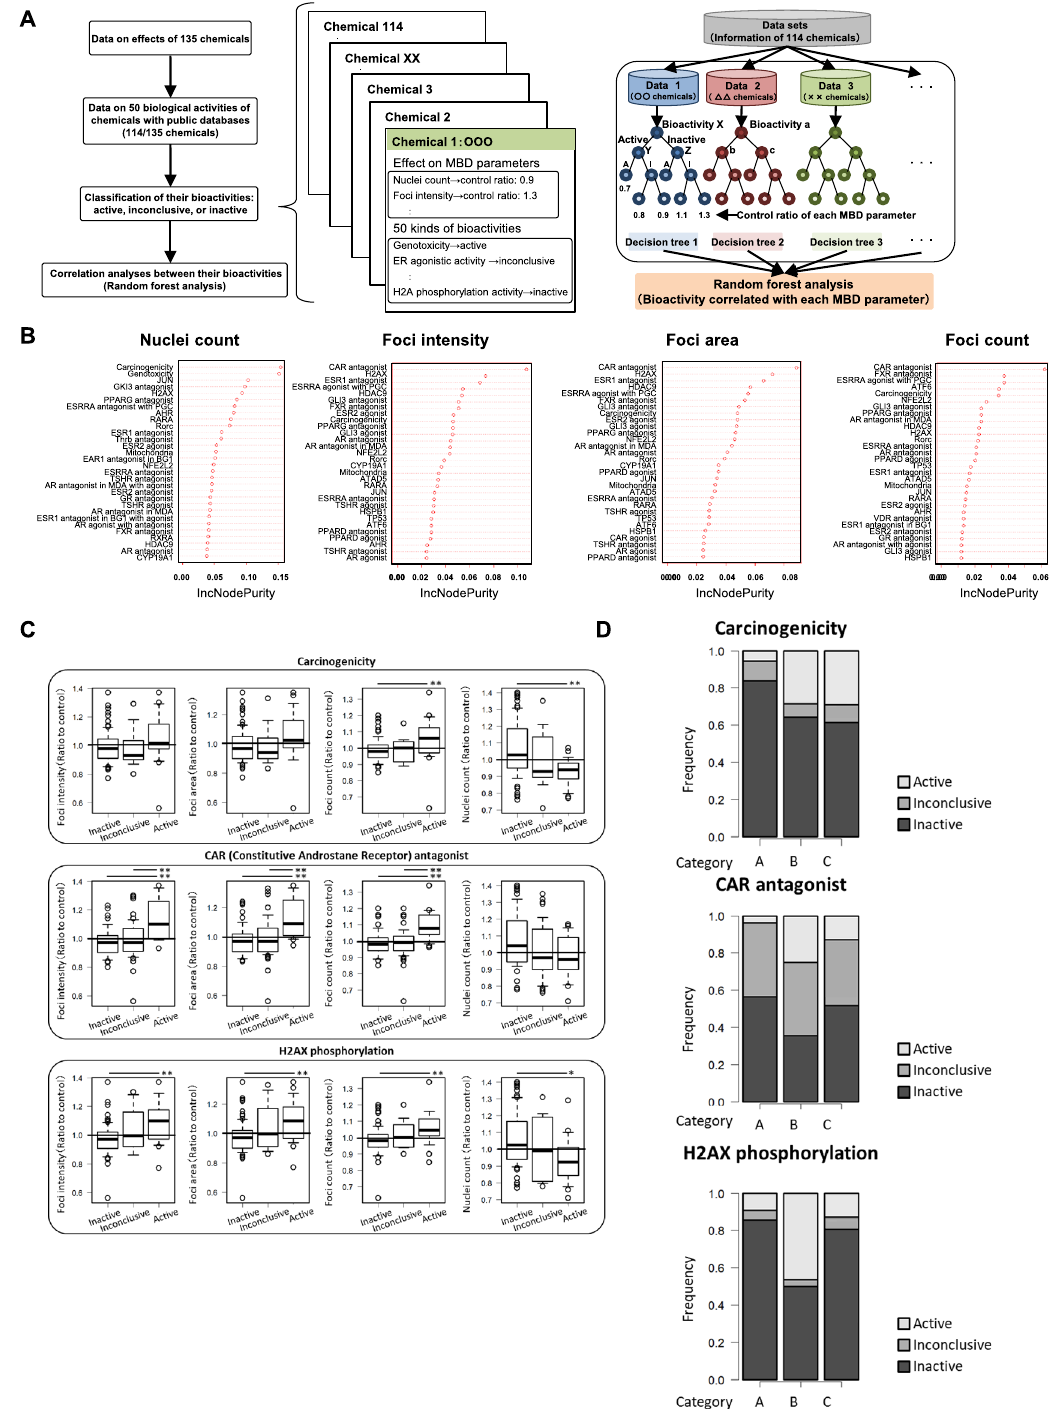
Figure 3. Machine learning-based physiological characterization using public databases. ( A ) Scheme of the random forest correlation analysis between epigenetic activities and physiological bioactivities of test compounds. The physiological bioactivity data were retrieved from the GENE-TOX, CCRIS, IARC monographs, and Tox21 databases. ( B ) Top 30 physiological bioactivities that highly correlated with the fluorescent MBD parameters according to the feature importance from the Increase in Node Purity. ( C ) Box plots of the distributions of fluorescent MBD parameters in chemicals with active, inconclusive, and inactive carcinogenicity, CAR antagonistic, and H2AX phosphorylation activities ( D ) The distributions of carcinogenicity, CAR antagonistic, and H2AX phosphorylation activities in categories A, B, and C. * P < 0.05; ** P <